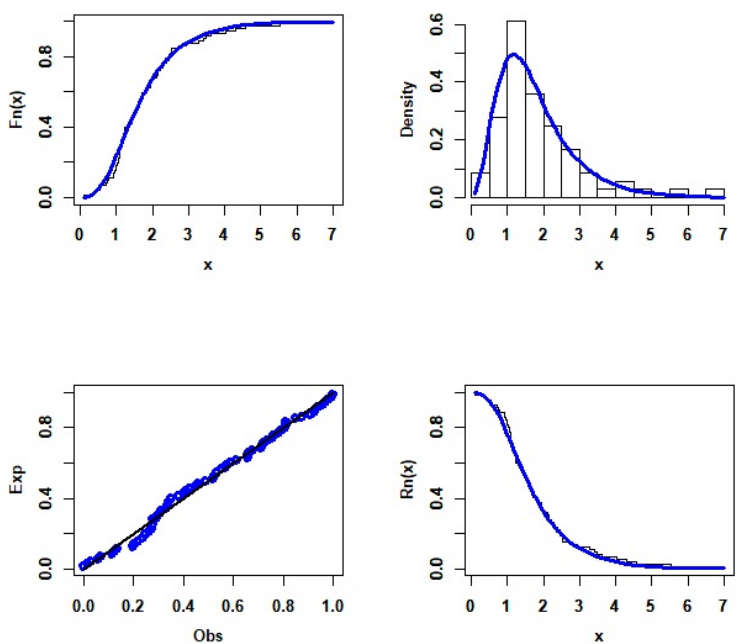
Figure 6. The fitted cdf, pdf, and pp plots and the estimated plot for the first data set.